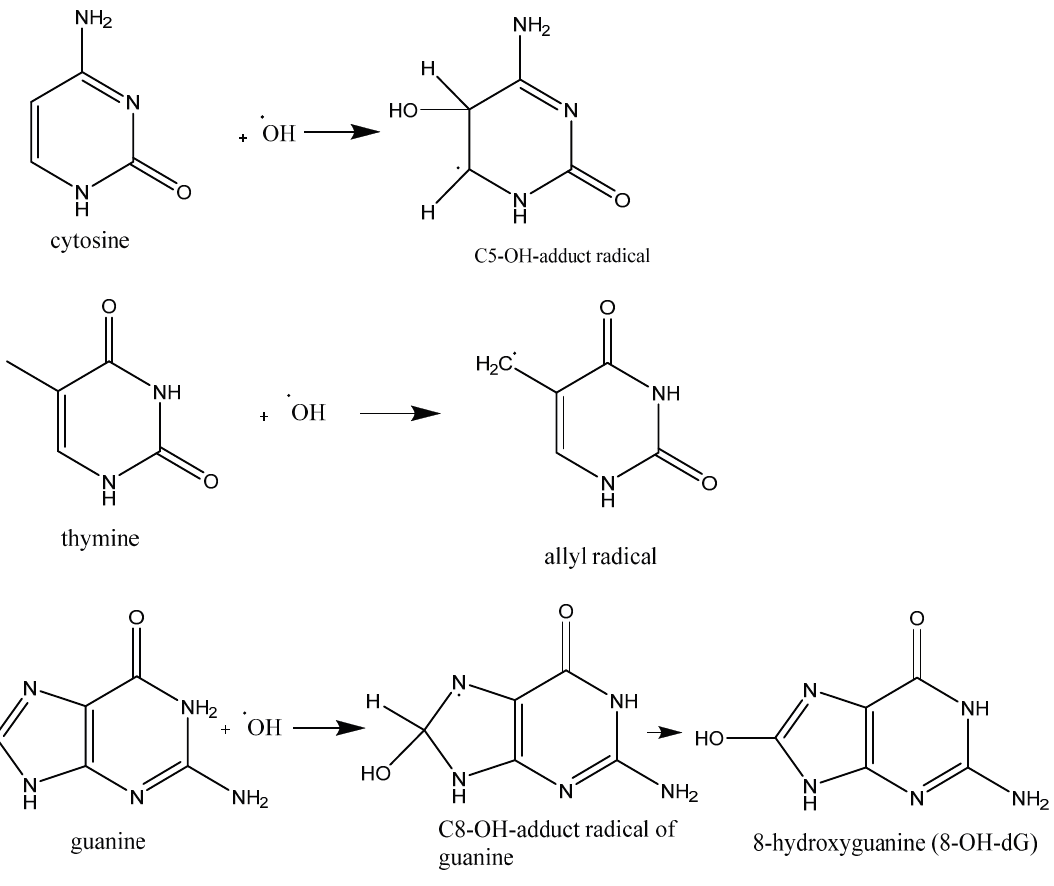
Figure 3. Reactions of ·OH radical with DNA nitrogenous bases cytosine, thymine and